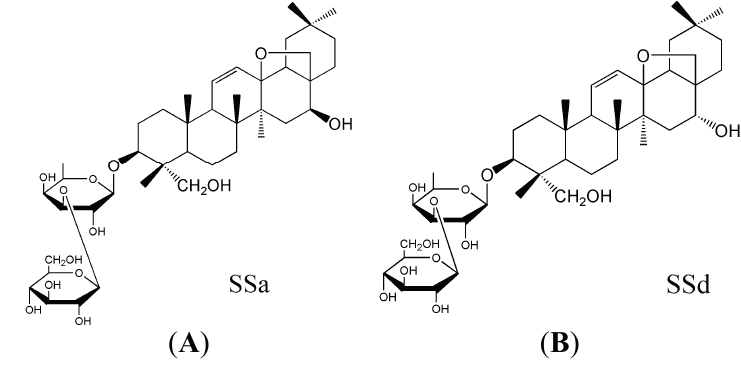
Figure 1. The chemical structure of SSa ( A ) and SSd ( B